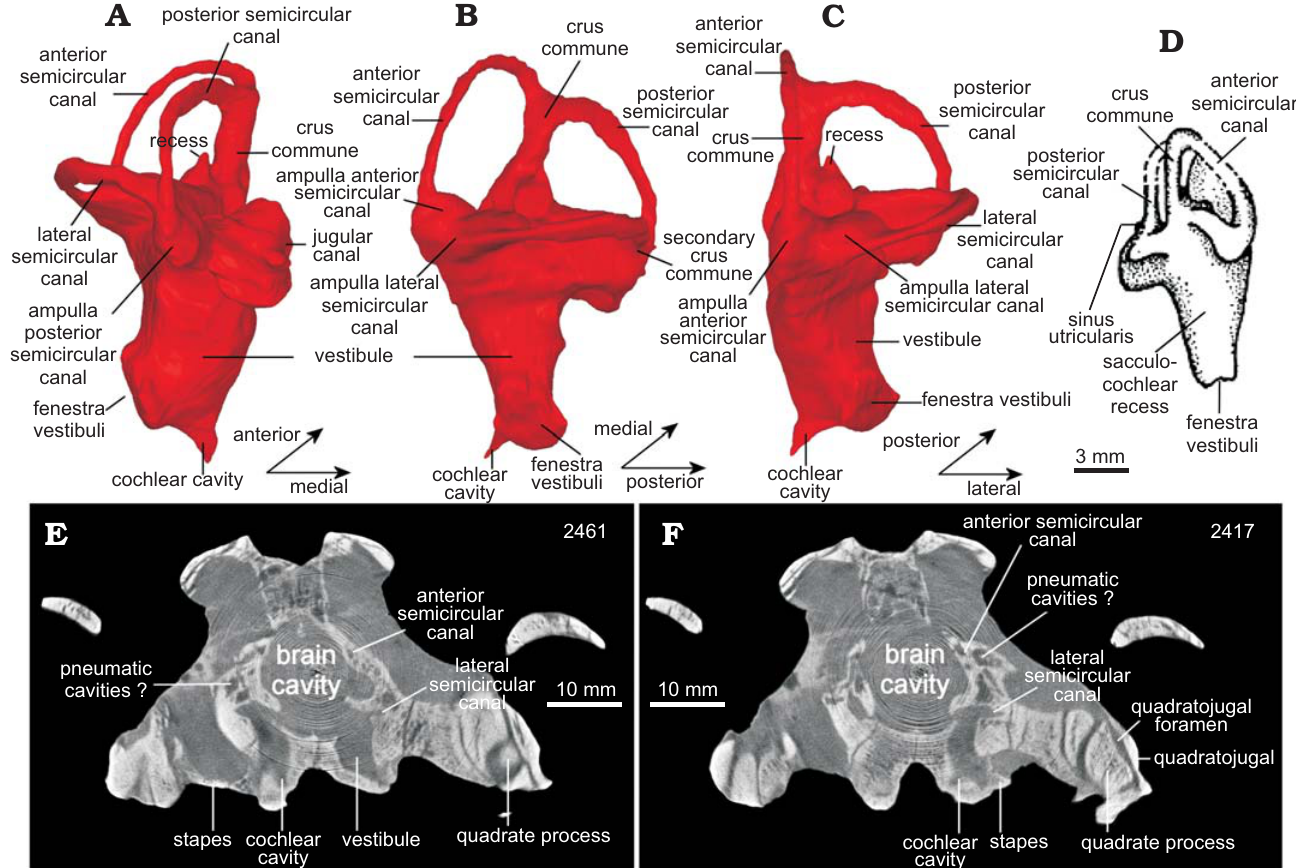
Fig. 2. The inner ear labyrinth of the non-mammalian synapsid Pristerodon mackayi Huxley, 1868 (MB.R.985) from the Late Permian of Biesjespoort, South Africa. Virtual cast of the left inner ear labyrinth in posterior ( A ), lateral ( B ), and anterior ( C ) views. Otic region including cochlear cavity of the left ( E , tomographic slice 2461) and right ( F , tomographic slice 2417) inner ear. D . Inner ear reconstruction of Pristerodon by Barry